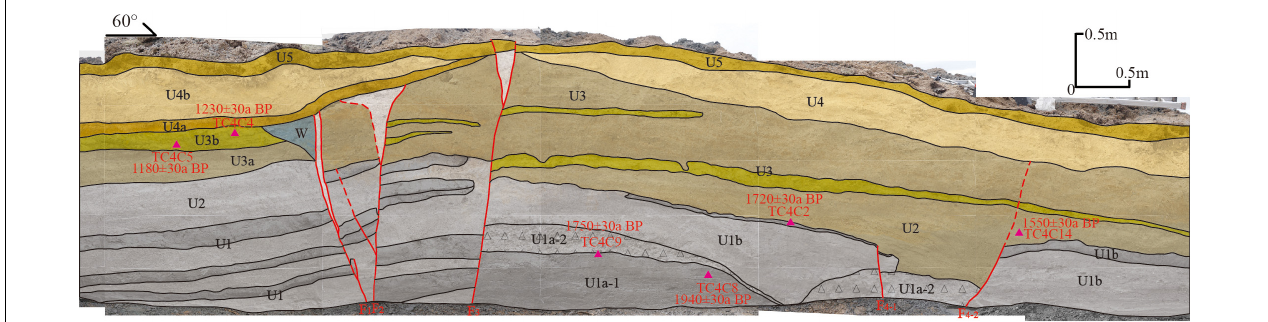
FIGURE 12 | The exposed northwestern wall and geological section of trench TC3 showing stratigraphic units U1–U5. The purple triangles mark the collecting positions of the samples used for carbon dating.